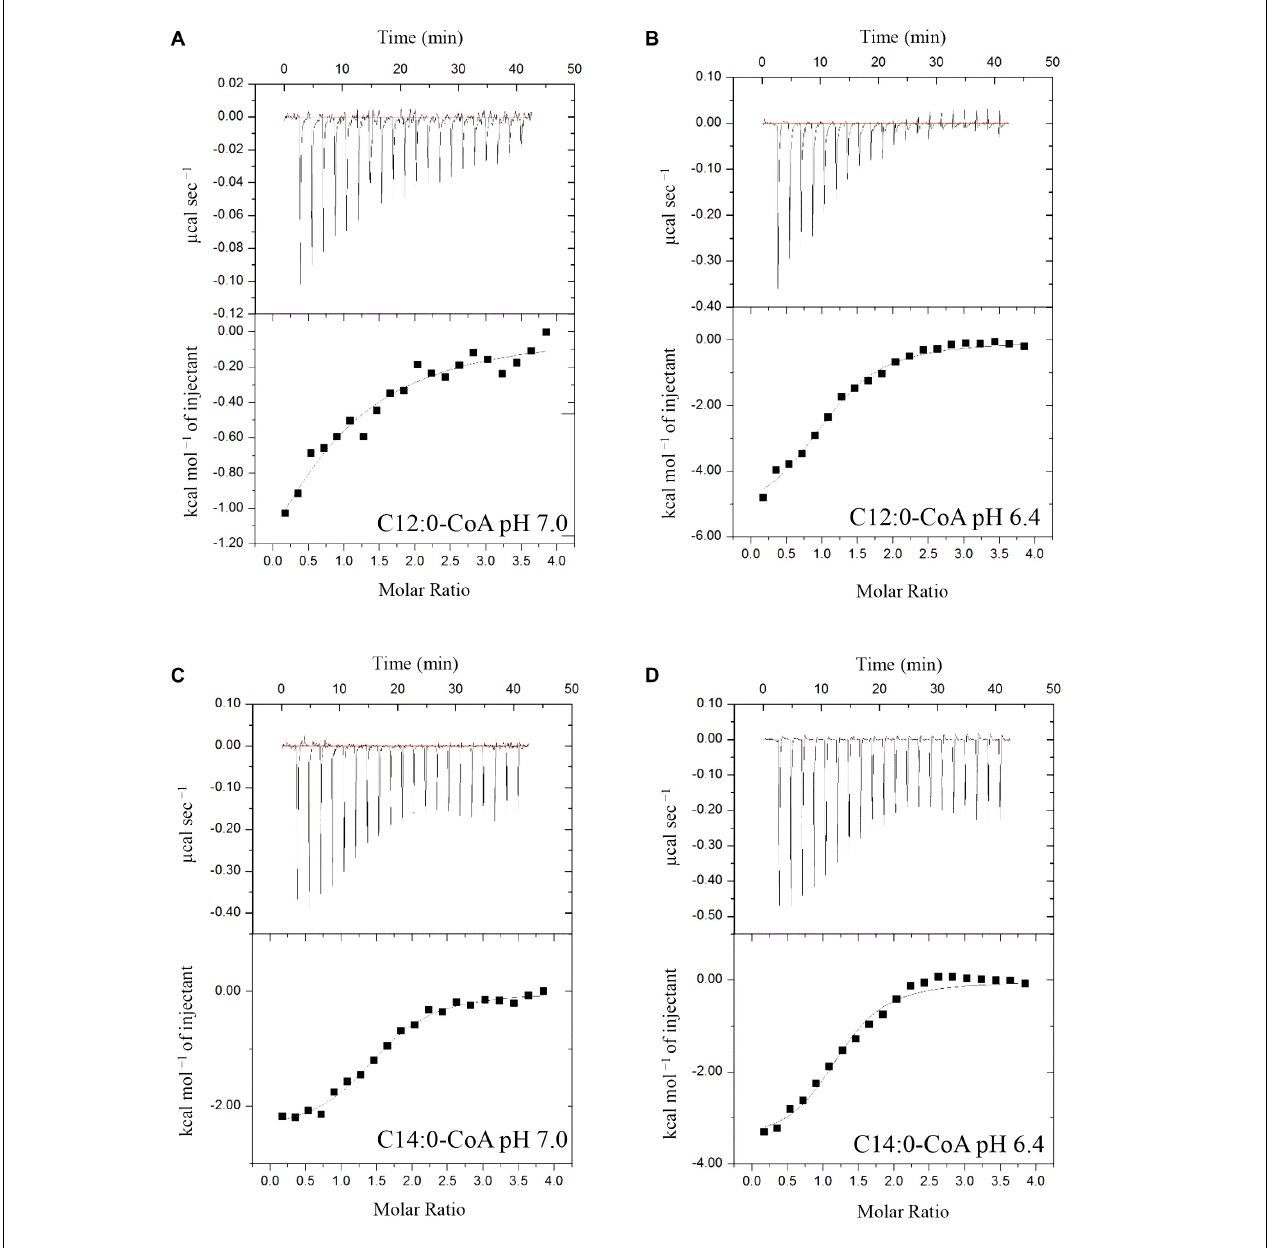
FIGURE 6 | Binding isotherms of recombinant (His) 6 -AtACBP3 titrated with C12:0- and C14:0-CoA esters at 25 ◦ C in isothermal titration calorimetry. The panel shows raw data of 30 µ M recombinant (His) 6 -AtACBP3 titrated with 600 µ M of C12:0-CoA ester, pH 7.0 (A) ; C12:0-CoA ester, pH 6.4 (B) ; C14:0-CoA ester, pH 7.0 (C) and C14:0-CoA ester, pH 6.4 (D) . Each assay had three technical repeats and was repeated at least twice, each using independently prepared (His) 6